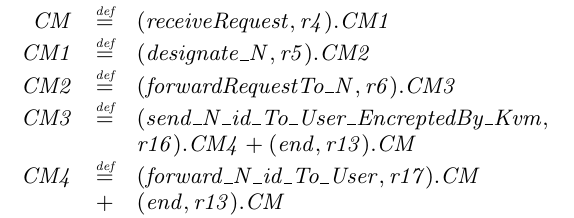
Figure 1: TCCP message exchange during